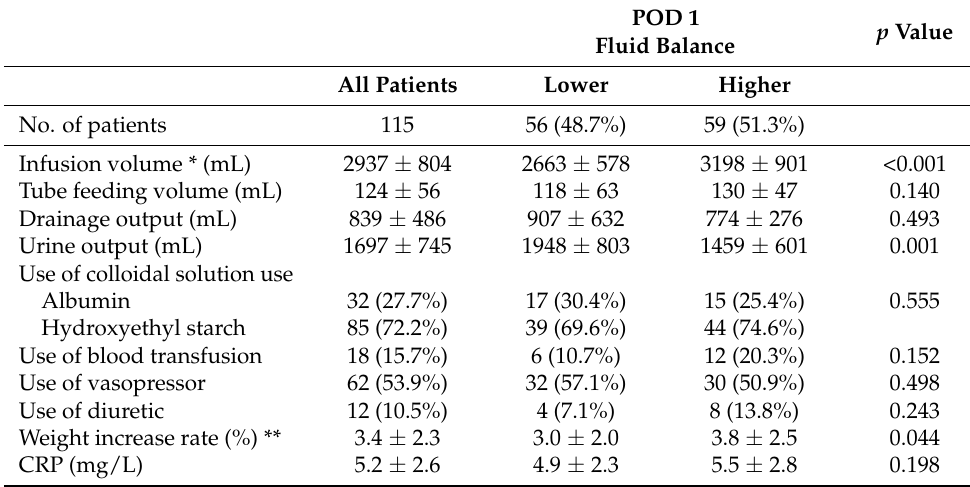
Table 4. Postoperative course at POD 1 in the